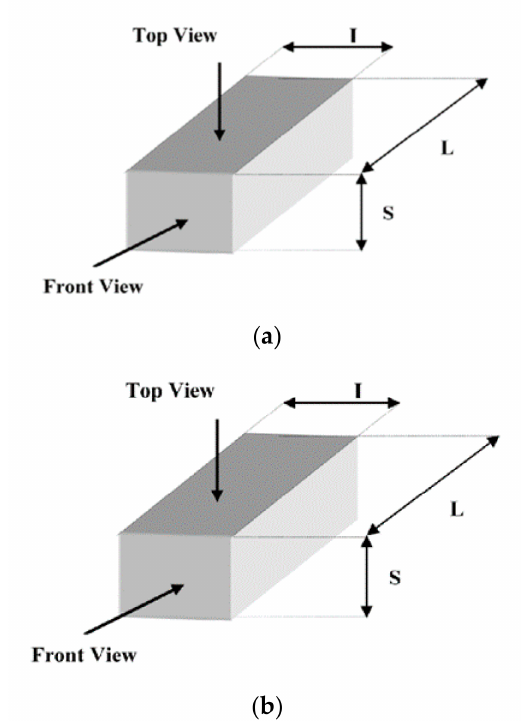
Figure 1. Research methodology flow chart.